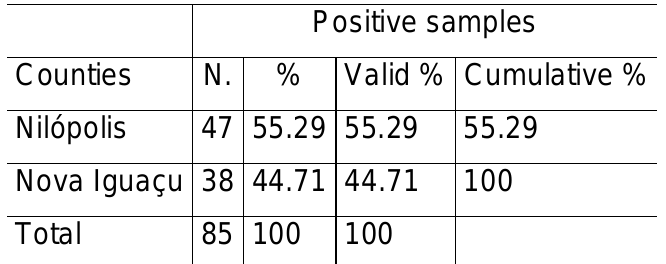
Table 1: Frequency of samples positive for bacteria and fungi in the hydrotherapy units evaluated in two counties from Rio de Janeiro State, Brazil.